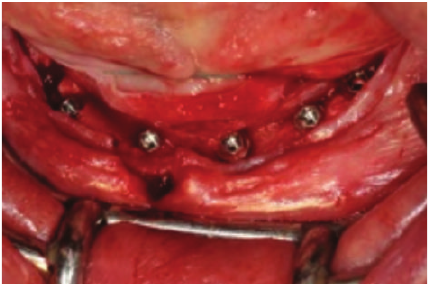
Figure 6: An image, out of focus, with the implants’ position too buccal.